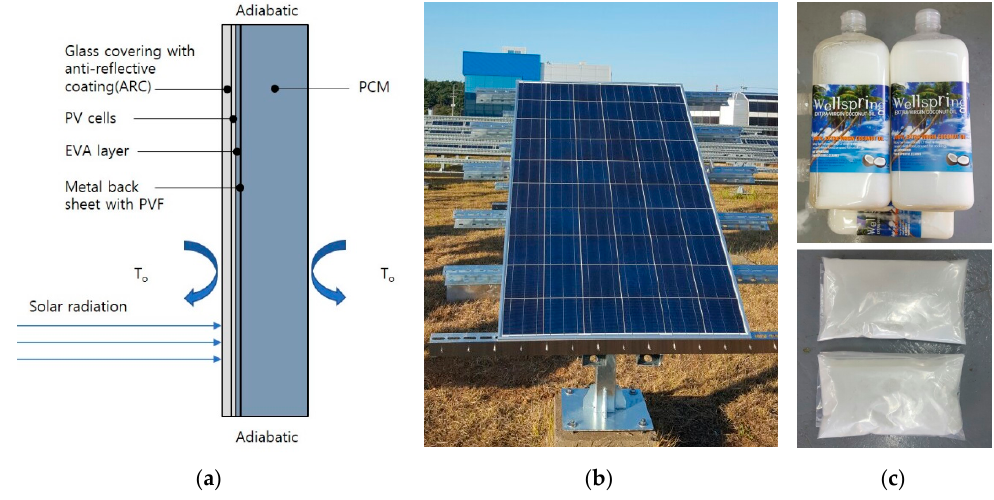
Figure 2. Thermal model for PV panel with PCMs: ( a ) schematic diagram of thermal model; ( b ) and example of a polycrystalline PV panel; and ( c ) an example of a PCM and macro-type container in the nylon bag. Table 1. Physical properties of PV layers and PCMs.